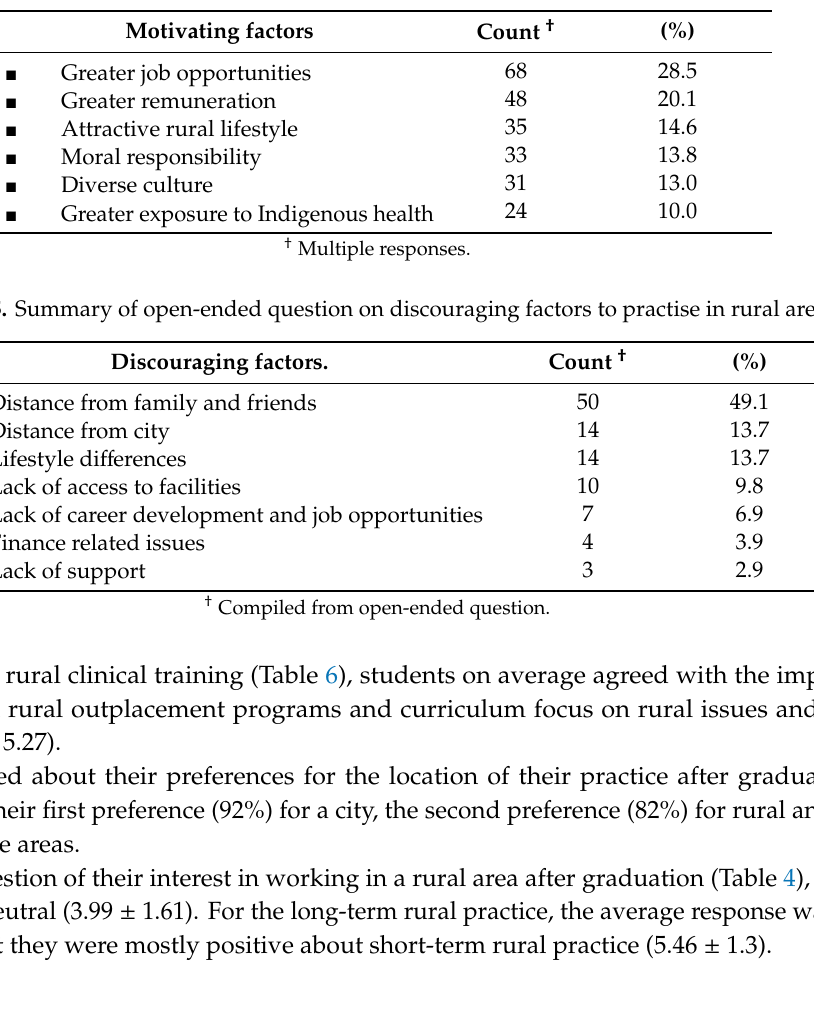
Table 4. Responses to specified motivating factors for decision to practise in rural area.